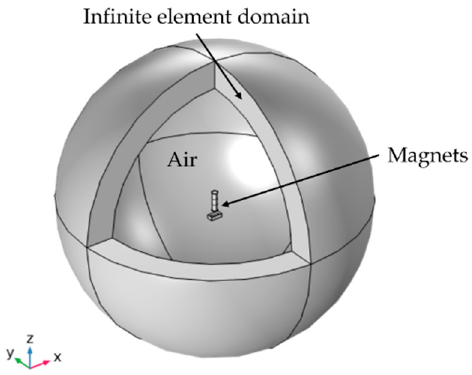
Figure 13. FEM model setup for calculating the magnetic forces between tip and external magnet.